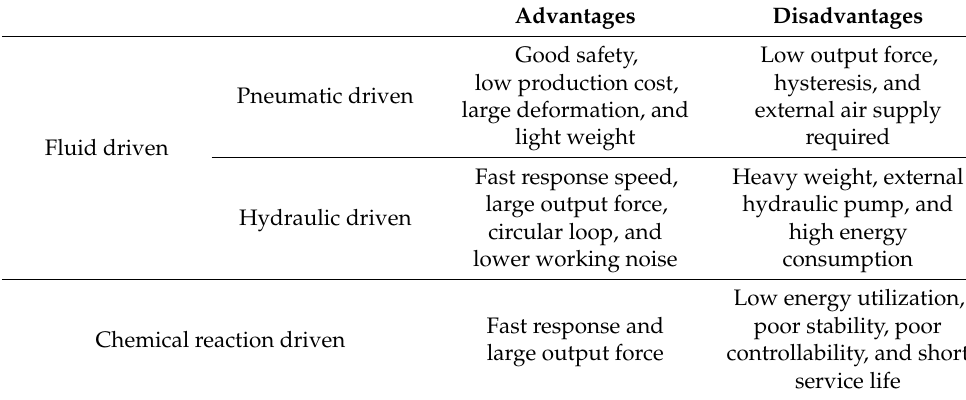
Low output force, hysteresis, and external air supply required Heavy weight, external hydraulic pump, and high energy consumption Low energy utilization, poor stability, poor controllability, and short service